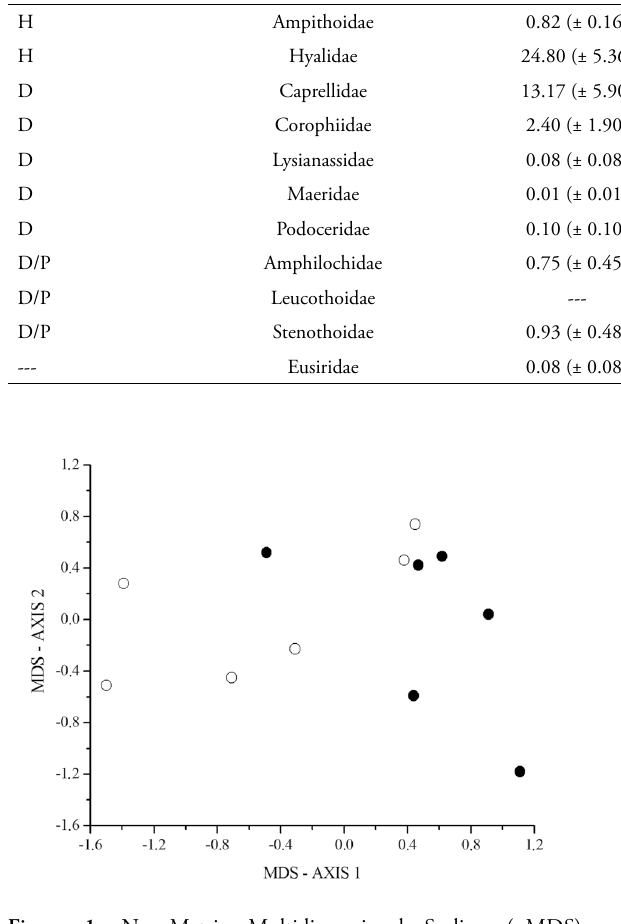
Table 1. Mean density (ind/g of dry algae) (± standard error) of the amphipod families associated to different portions of the Sargassum stenophyllum thallus. H = herbivore; D = detritivore; P = predator. Feeding